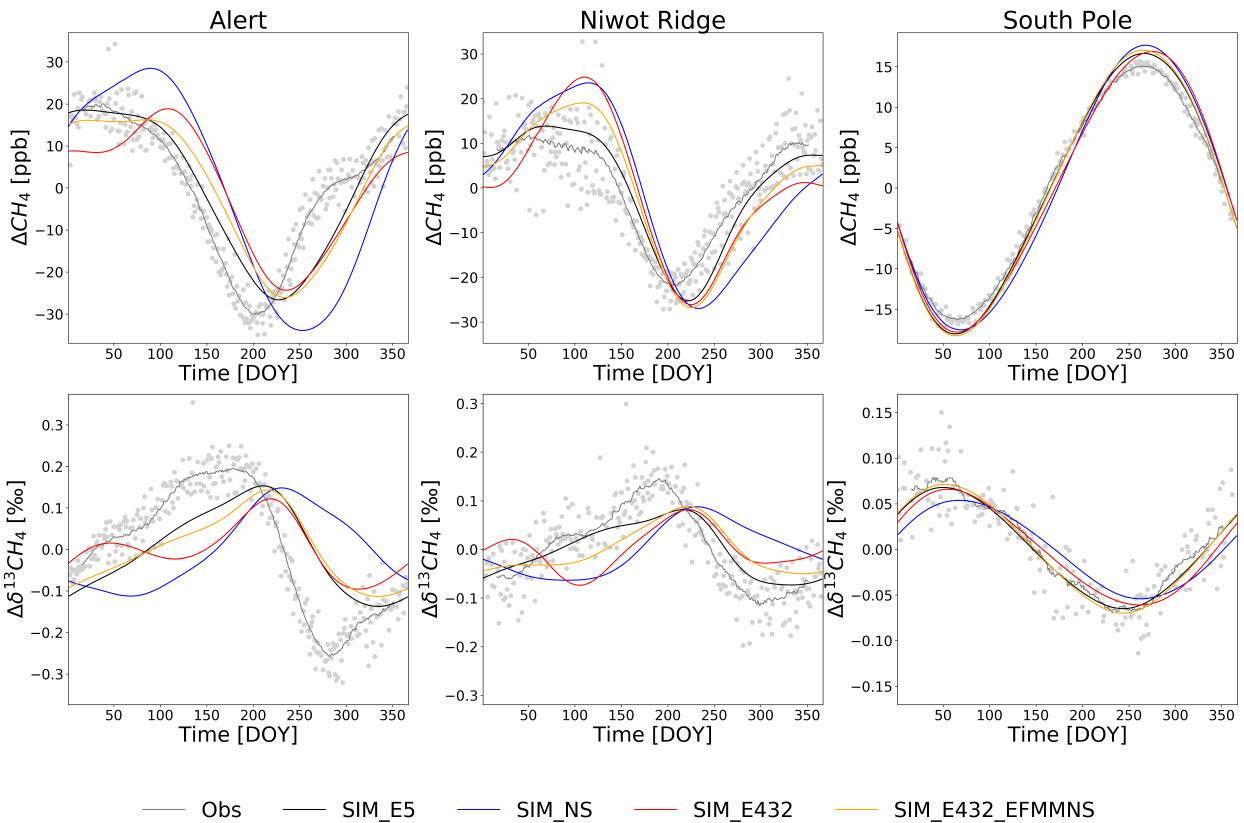
Figure 4. De-trended modeled and observed average seasonal cycles during 2002–2012 at Alert, Niwot Ridge, and South Pole. Gray dots are individual de-trended observations. Note the different ranges in the y-axis scales.